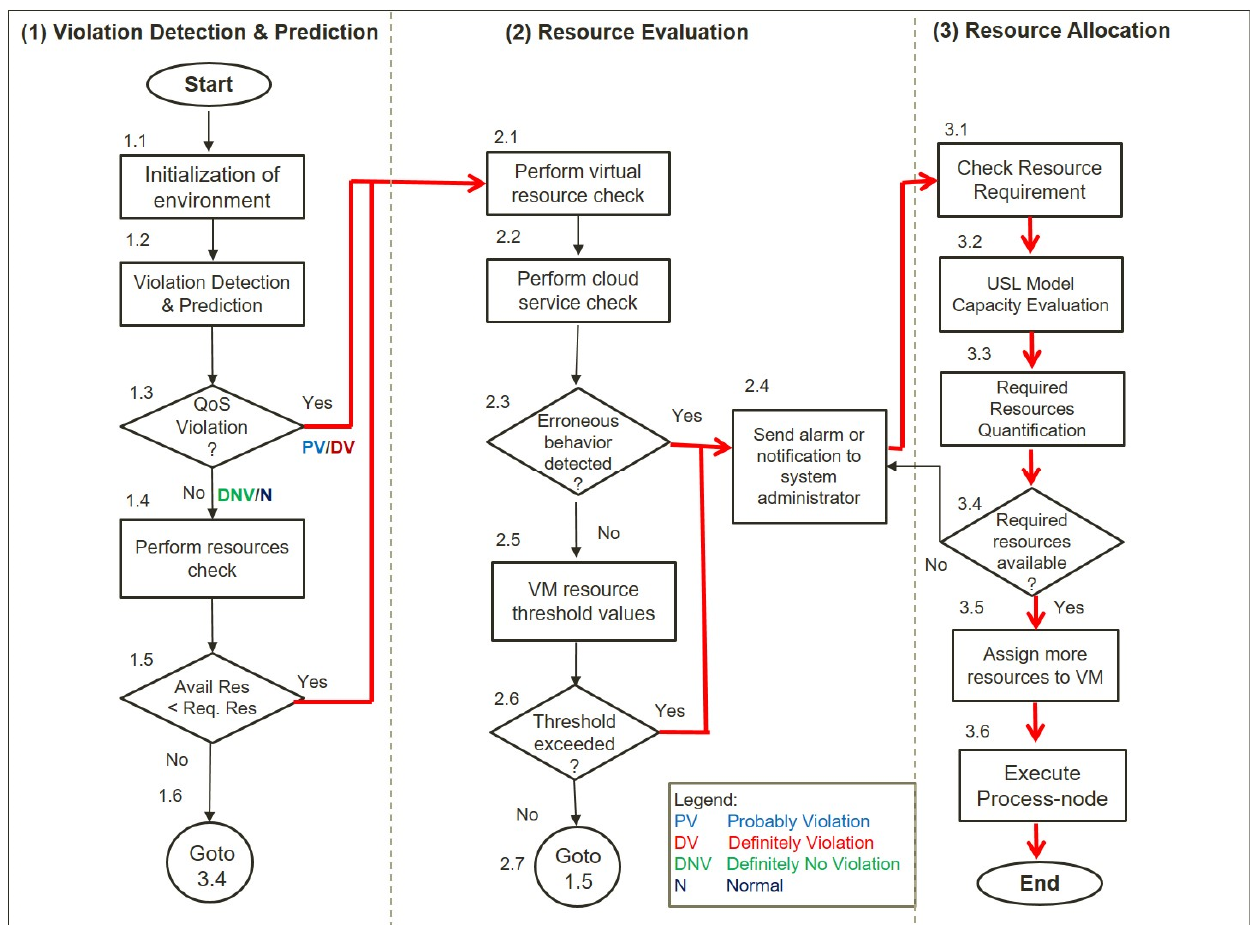
Figure 3. Flow diagram of the ReSQoV model. Resource Allocation: the resource requirement is determined by the value of the con- tention and coherence parameters. As more workload is assigned, it fluctuates (serialization or queuing). The serialization and queuing occur when more workloads are executed on certain resources and the required resources are less than available. During the resource scheduling process, resource contention is measured using USL. Increasing the number of resources (CPU cores, RAM) boosts throughput while lowering response time. The base for the additional resource allocation is the ideal contention value. The USL model and its prediction outputs will calculate resource requirements, and when the required resources are available, resources are assigned to VM. The following Algorithm 1 presents the intents of the proposed mechanism for resource